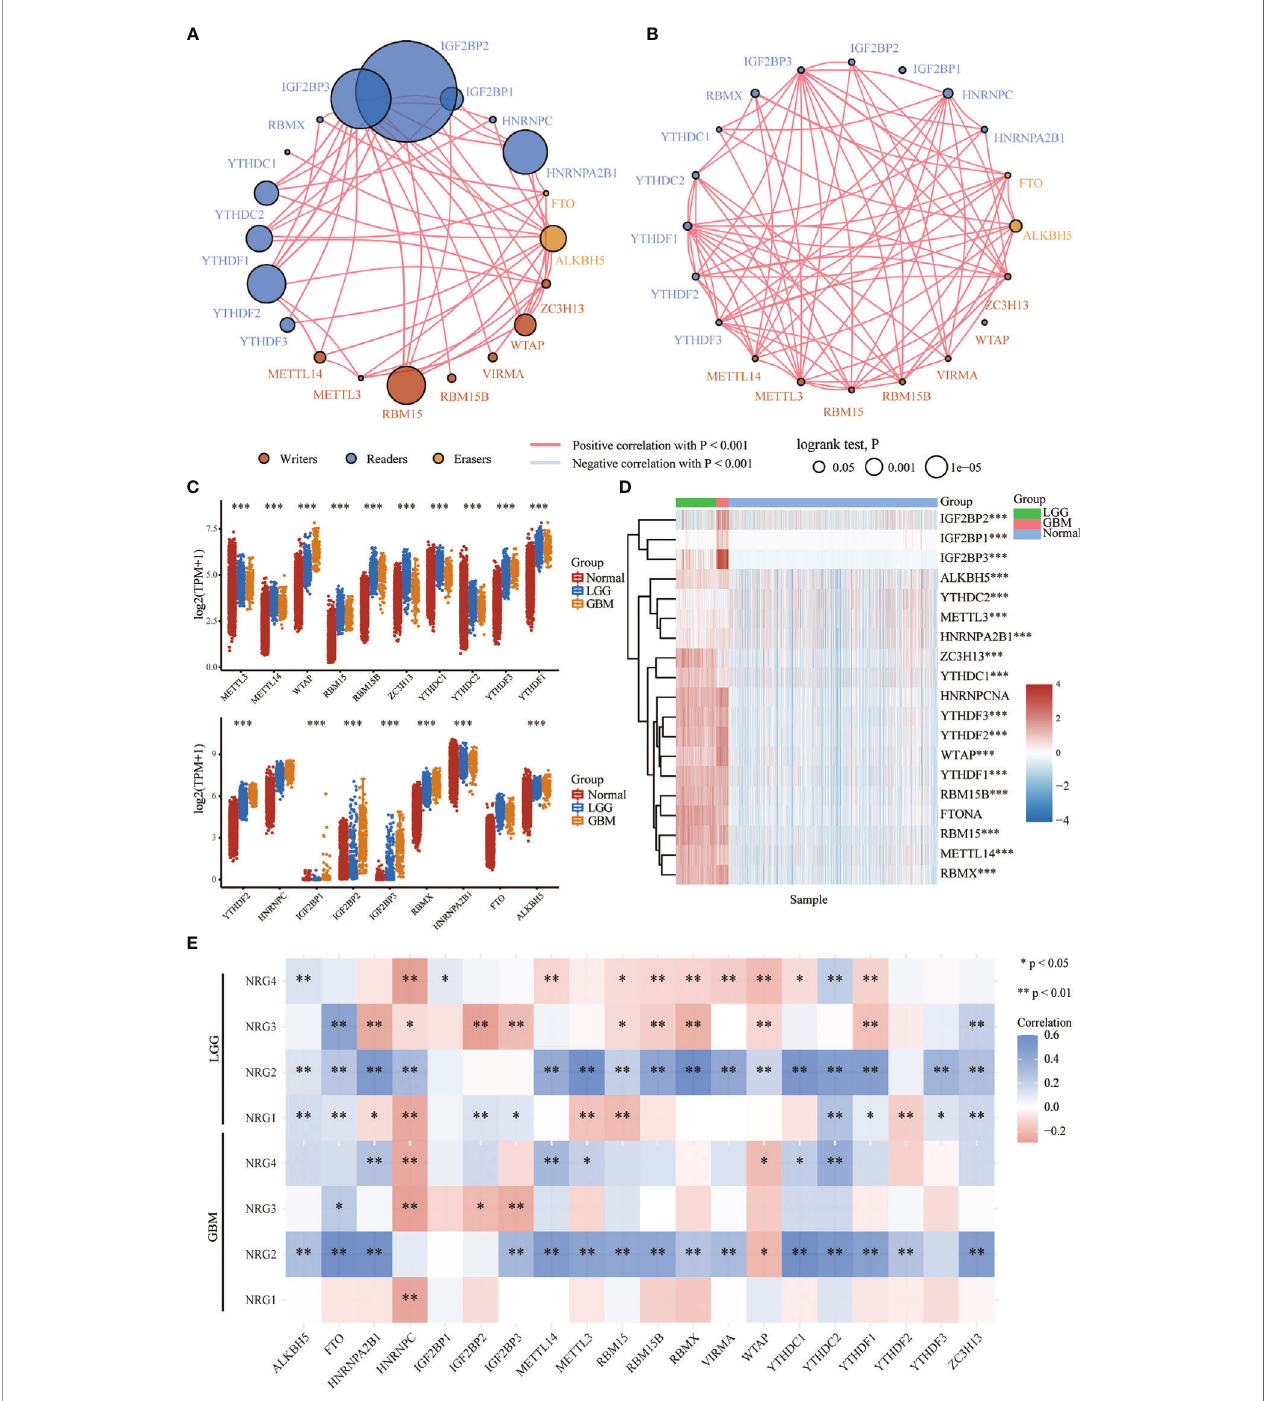
FIGURE 8 | The expression distribution of the m 6 A-related genes in LGG and GBM. Correlation network analysis of the m 6 A-related genes in LGG (A) and GBM (B) . The circle represents the m 6 A-related genes, and the line represents the relationship between genes. The red represents the positive correlation and the blue represents the negative correlation, with lines of different thickness representing the extent of correlation between two genes. Larger circles represent higher prognosis log-rank p, with the brown, blue and orange circles representing writers, readers, and erasers, respectively. Expression level of m 6 A-related genes in LGG and GBM (C) , and expression distribution heatmap of m 6 A-related genes in LGG and GBM, where different colors represent the expression trend in different samples (LGG: n=510, GBM: n=153, Normal tissue: n=2647) (D) . Correlations between m 6 A-related genes and the expression of NRG1-4 in LGG and GBM (E) . The signi fi cance of the different groups of samples passed the Kruskal-Wallis test, and Spearman ’ s correlation analysis was used to describe the correlation. *P < 0.05; **P < 0.01; ***P <